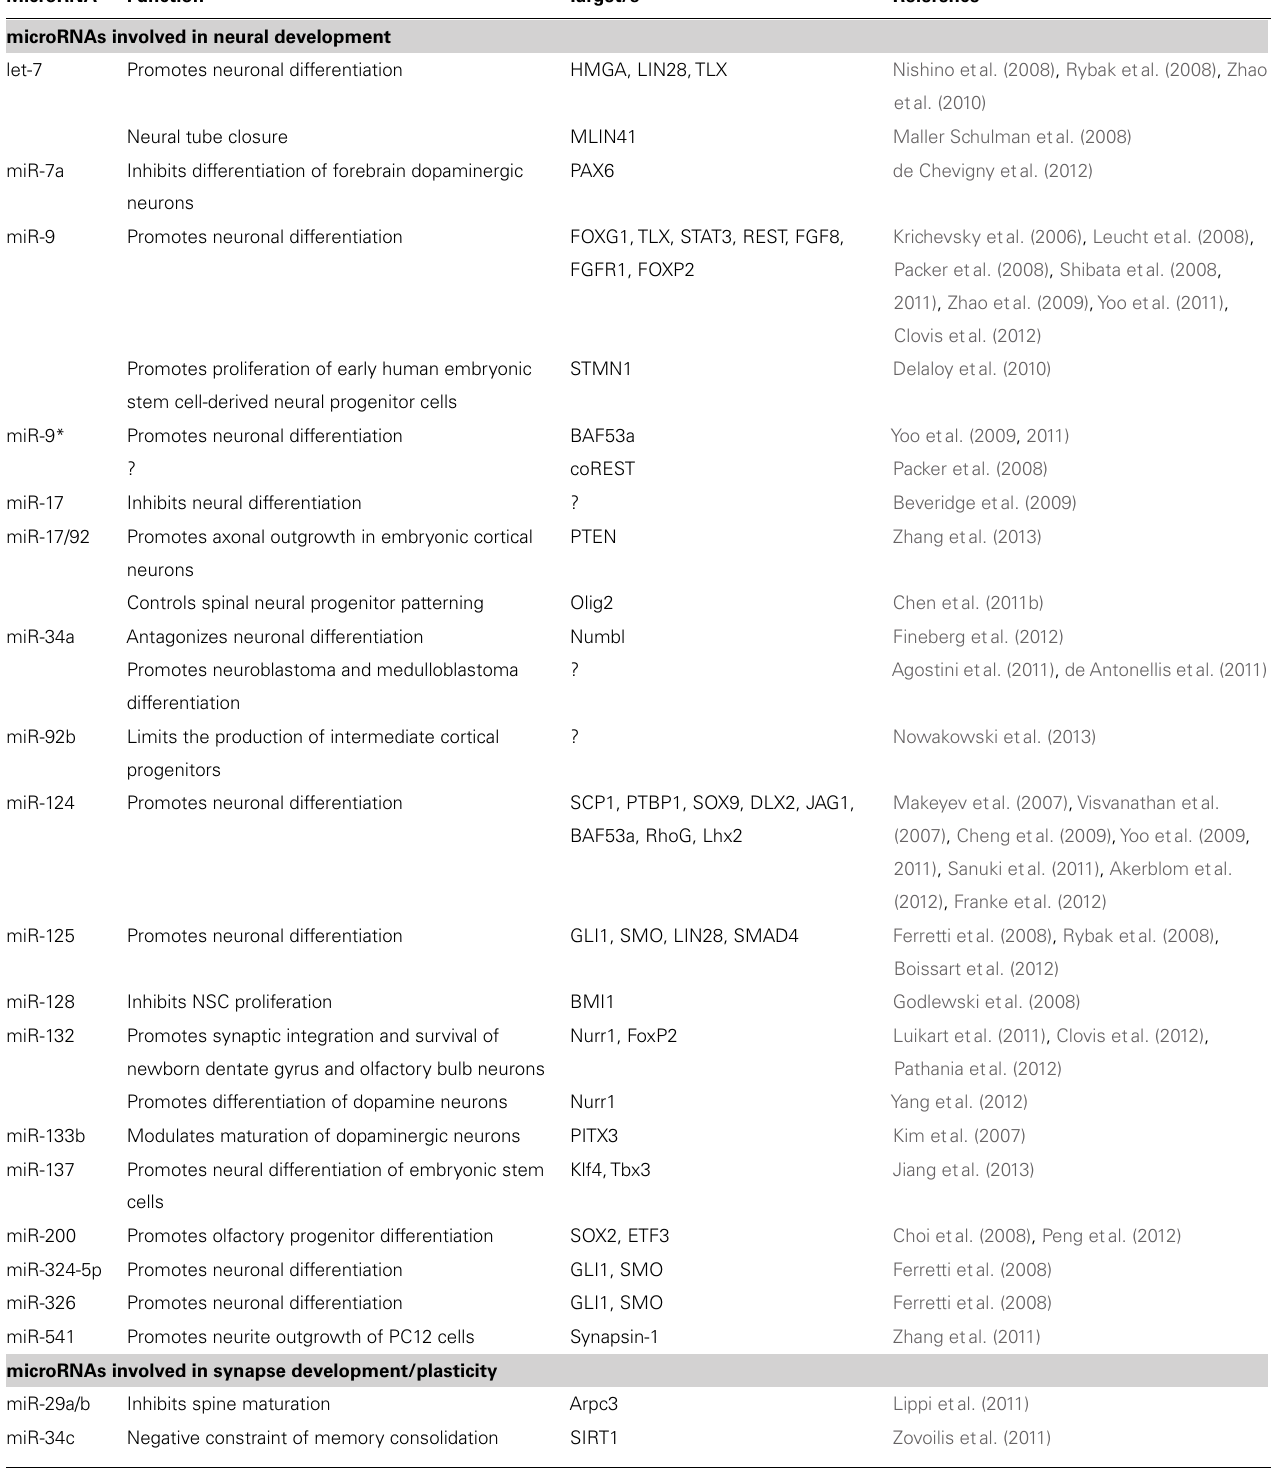
Table 1 | List of individual microRNAs involved in neural development and synapse development/plasticity and their mRNA targets in mice and men.